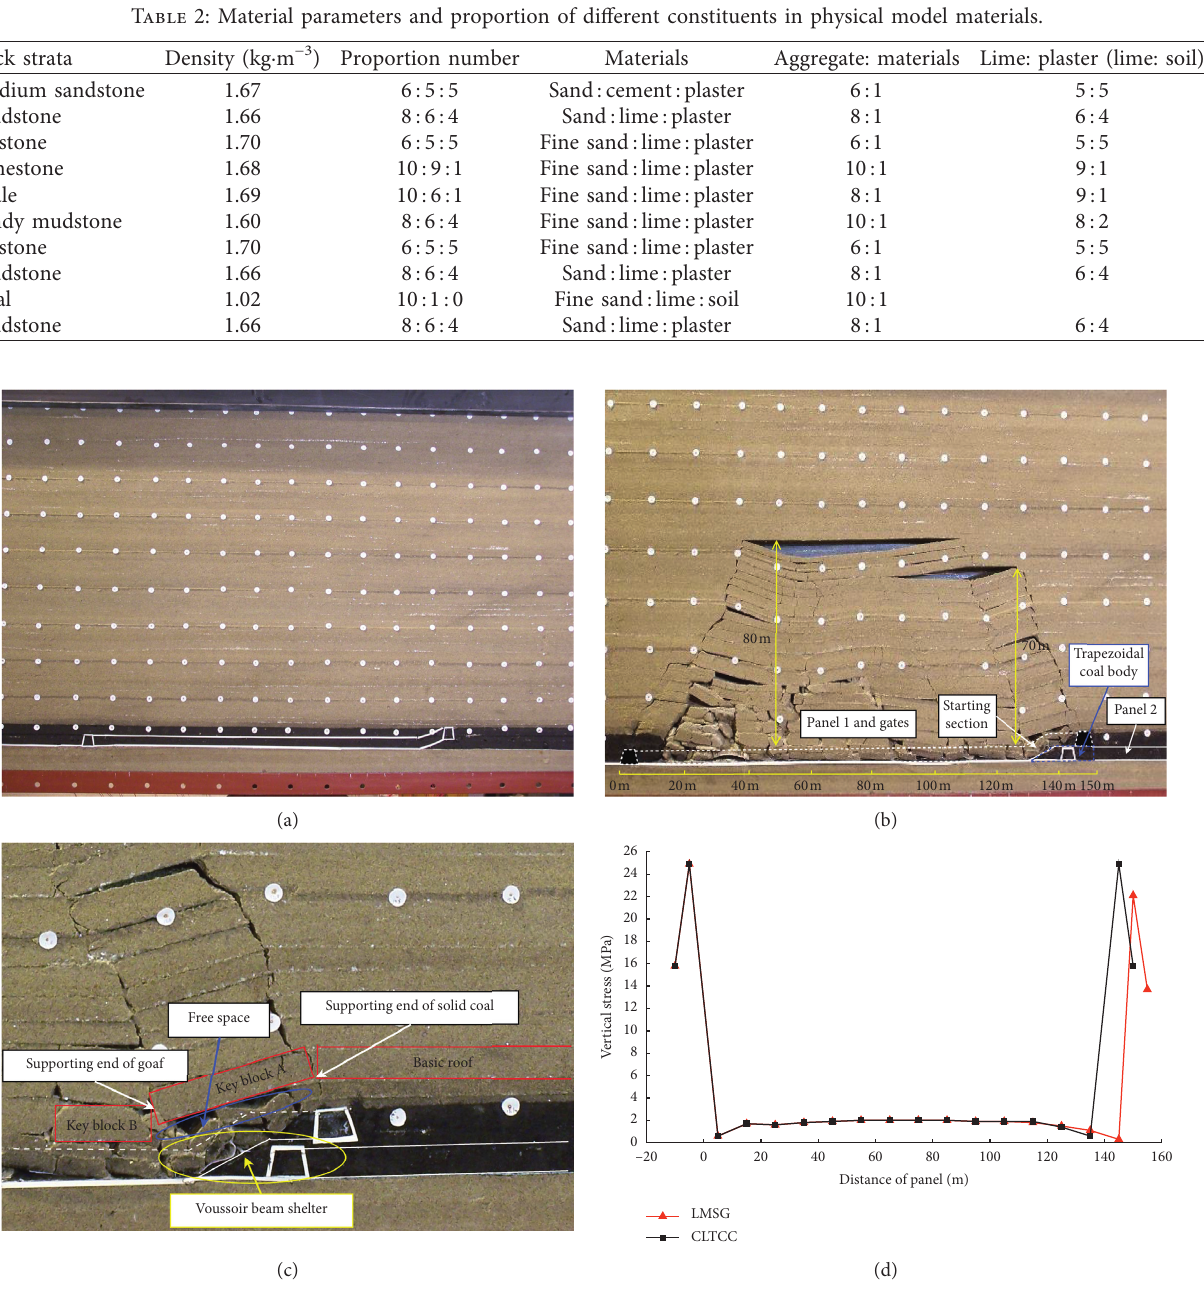
Figure 3: Physical modeling initial model and results. (a) Initial model. (b) Overlying strata characteristics. (c) Partial enlarged view. (d) Floor vertical